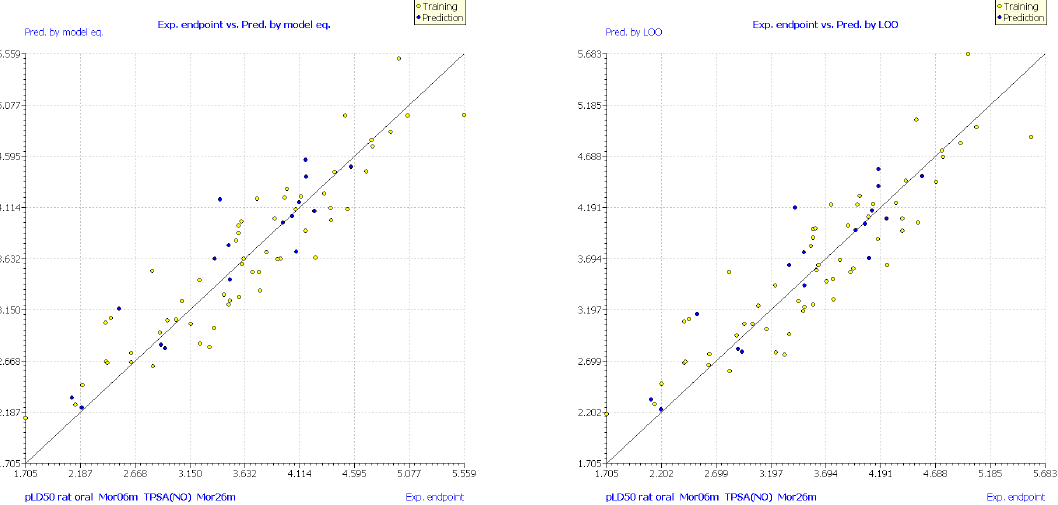
Figure 1. Plots of experimental versus predicted pLD 50 values for the MLR1 model predicted by the model ( left ) and by the leave-one-out ( right ) cross-validation approach (yellow circles-training compounds, blue circles-test compounds).